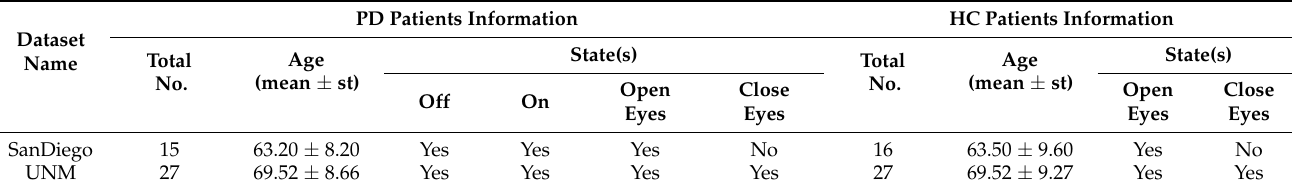
Table 2. Summary of information about datasets used in this study.